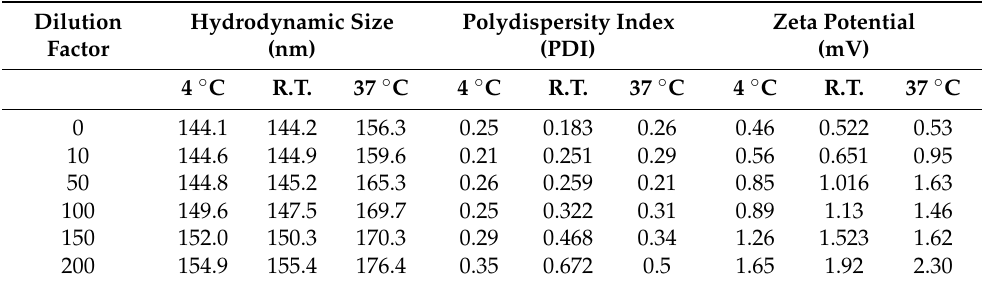
Table 3. HA − PTX+RTVNMF dilution study when stored at temperatures of 4 ◦ C, room temperature (RT), and 37 ◦ C for 24